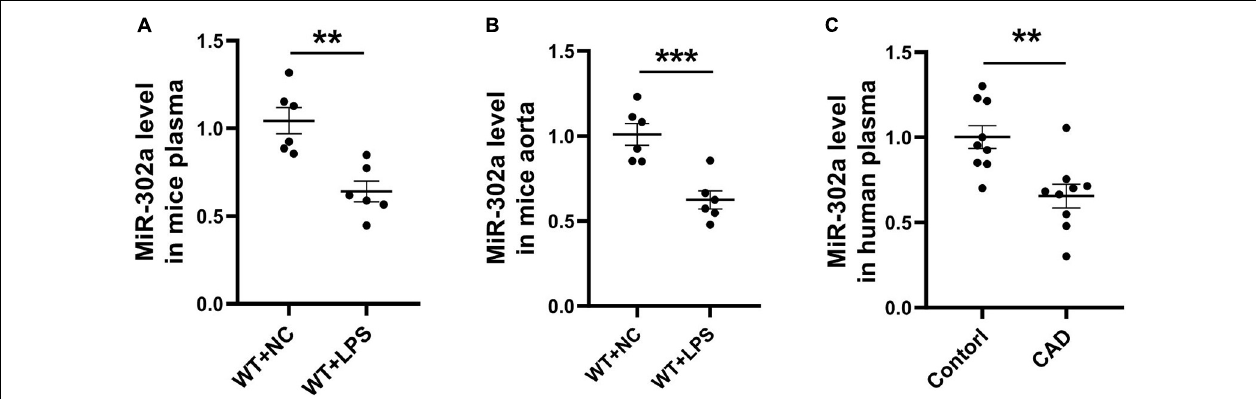
FIGURE 1 | MiR-302a is decreased in serum and vascular tissue under inflammatory condition. wild-type (WT) mice were intraperitoneally injected with 25 mg/kg LPS, mRNA level of miR-302a in serum (A) and aorta (B) of mice was detected by quantitative PCR after 96 h [** p < 0.01; *** p < 0.001 vs. Negative Control (WT + NC) n = 6]. (C) MiR-302a level in coronary heart disease (CAD) patients and control donors (Control) was examined by quantitative PCR (** p < 0.01 vs. control n = 9).